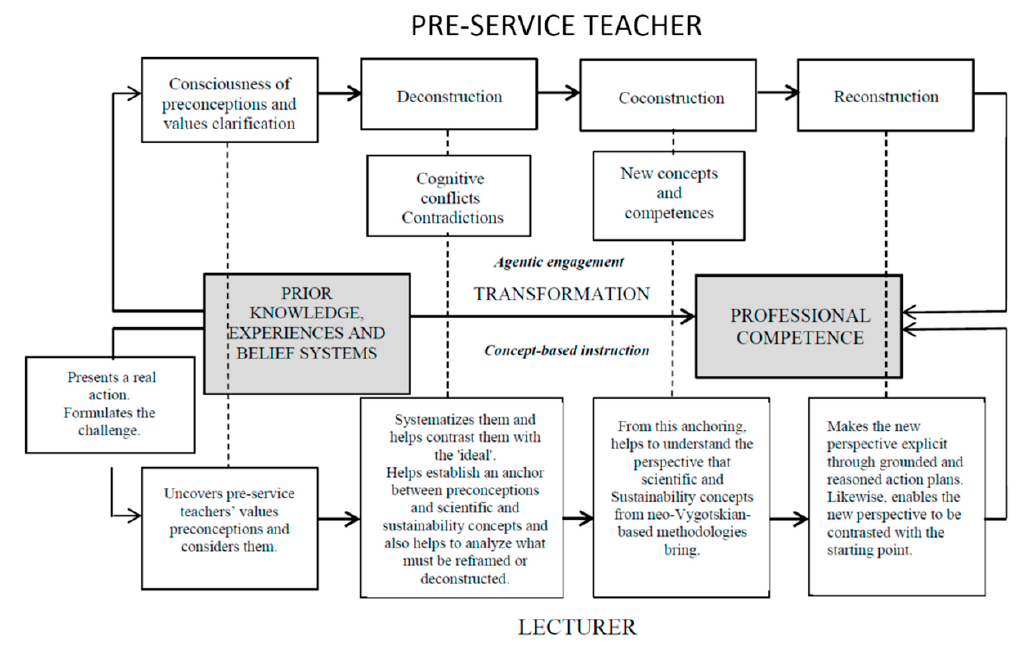
Figure 2. Elements of the transformation of prior knowledge, experiences, and belief systems into professional competence in teacher education [19] (p. 13).